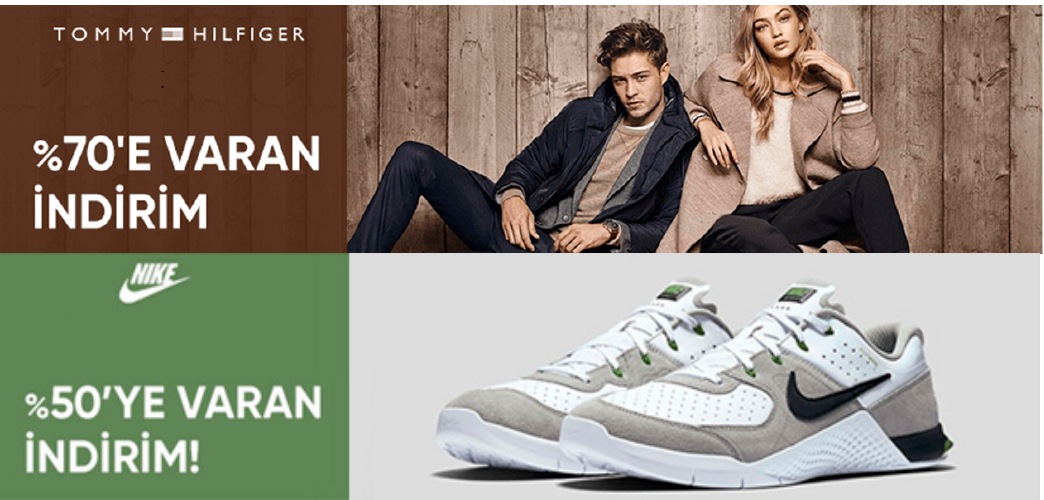
Figure A4. The banner ads numbered 4a ( above ) and 4b ( below ).